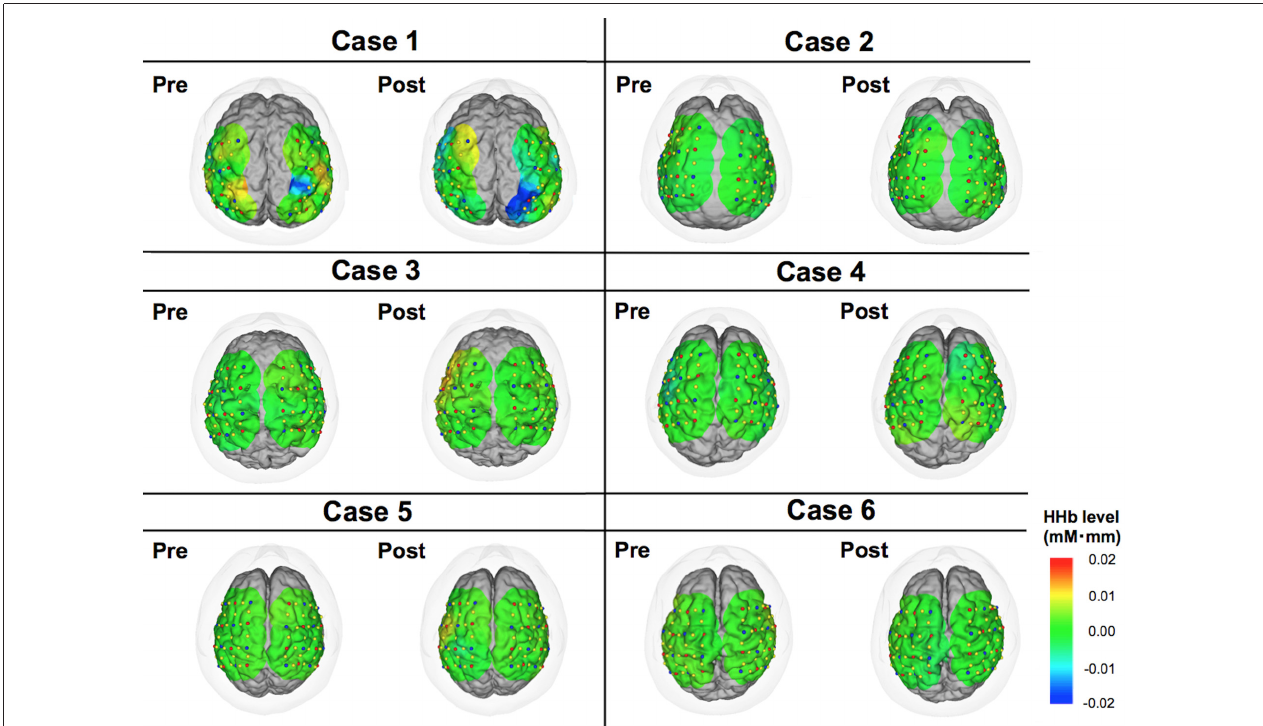
FIGURE 4 | Color maps of deoxy-hemoglobin (HHb) levels comparing pre- vs. post-DBS states. These images indicate cortical activities at 15 s from the start of motor task. Relative changes compared to the status at 0 s are demonstrated in this figure.